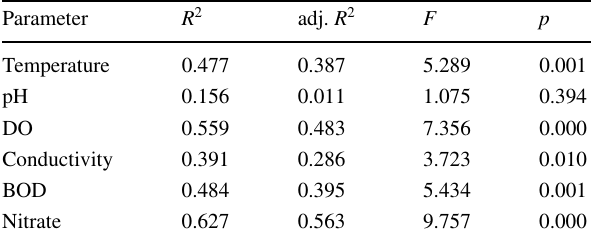
Table 5 One-way ANOVA for winter